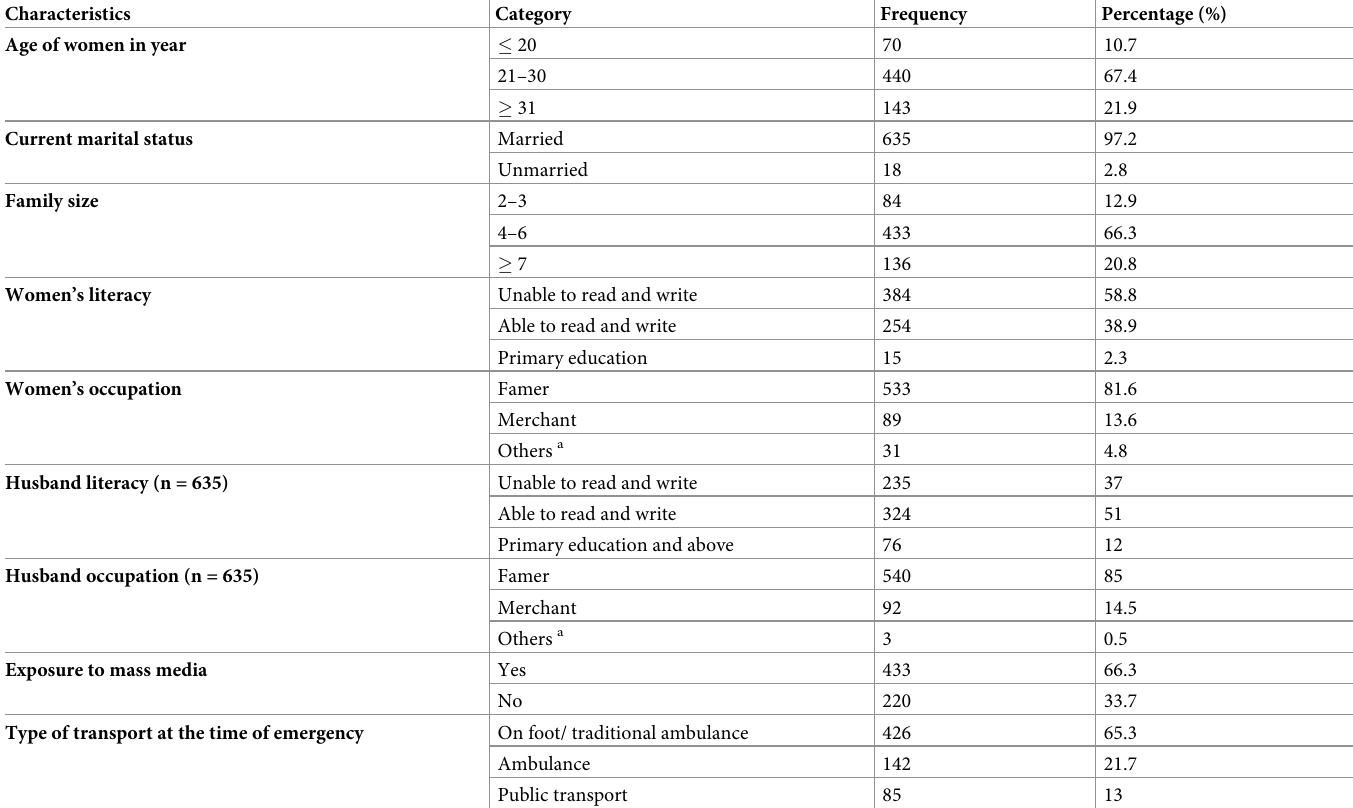
Table 1. Socio-demographic characteristics of study participants in rural Sehala Seyemit district, northern Ethiopia, 2020 (n = 653).